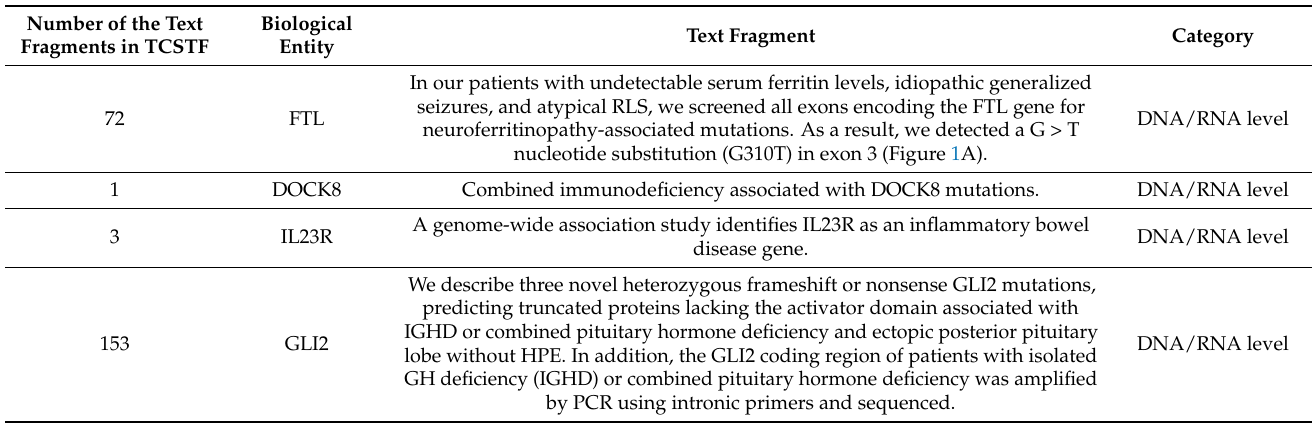
Table 1. Examples of text fragments belonging to the dictionary-defined category were validated during the manual review.